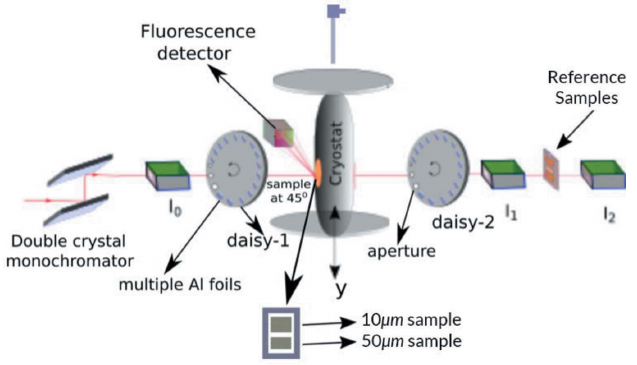
Figure 1 Experimental hybrid setup (Chantler et al. , 2012 b ) at the Australian Synchrotron. The sample holder in the cryostat is offset vertically to select the appropriate sample in the beam path. I 0 and I 1 take attenuation measurements of the sample in the cryostat, while I 1 and I 2 measure reference foils (Islam et al. , 2016). Daisy wheels, on either side of the sample, characterize harmonic and scattering systematics (Tran et al. ,